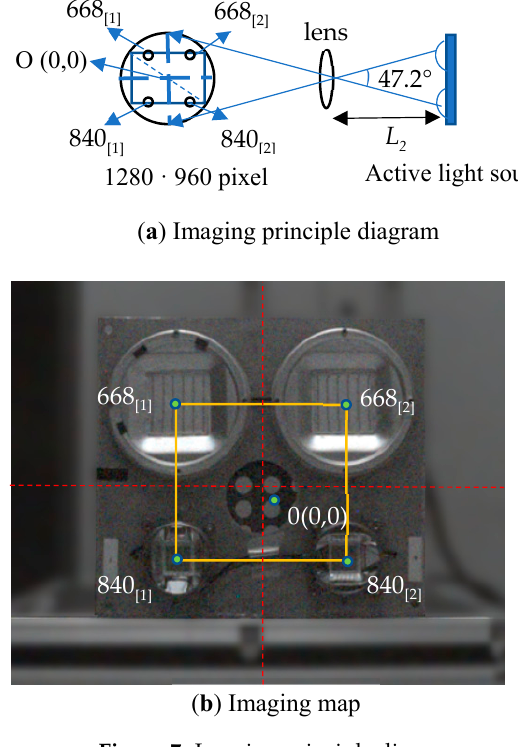
Figure 7. Imaging principle diagram. Table 6. Coordinate value and radiation intensity.